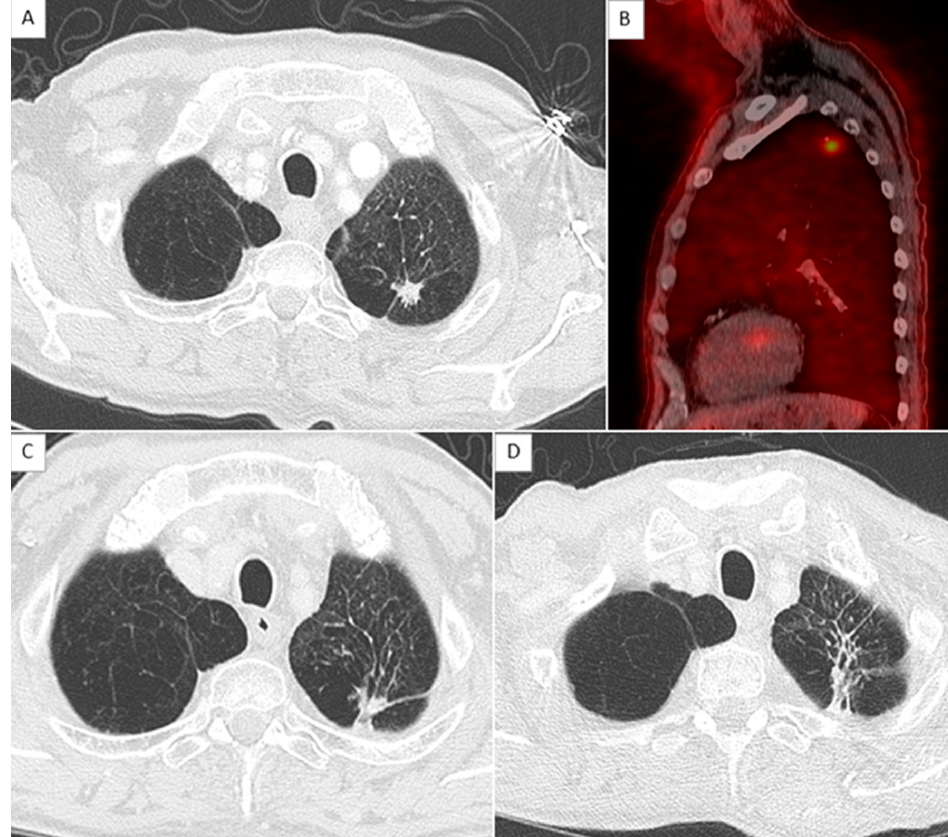
Figure 2. Example of the absence of local relapse with score at 0. ( A , C , D ) show axial chest CT in parenchymal window with an 11 mm nodule in the left apex corresponding to an adenocarcinoma, before, 1 year, and 2 years after stereotactic radiation therapy, respectively. ( B ) shows a sagittal reconstruction of merge PET and CT with a hypermetabolism of the nodule measured as SUV max = 4.2.